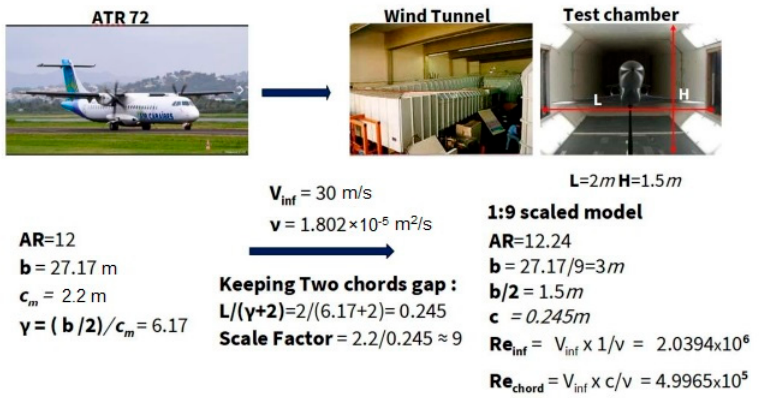
Figure 34. The scale factor for NACA 23012 airfoil.